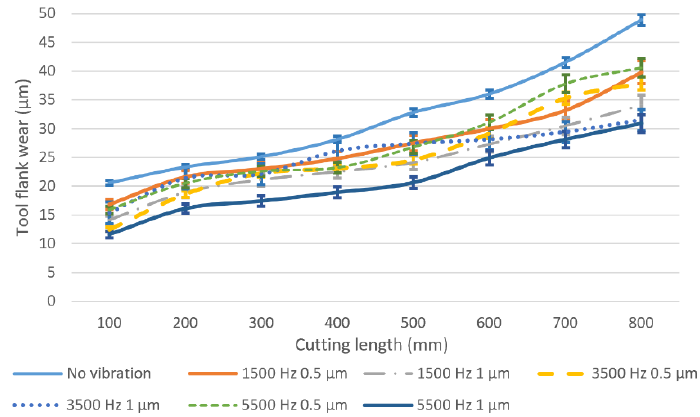
Figure 7. Tool flank wear under different vibration conditions and cutting length.